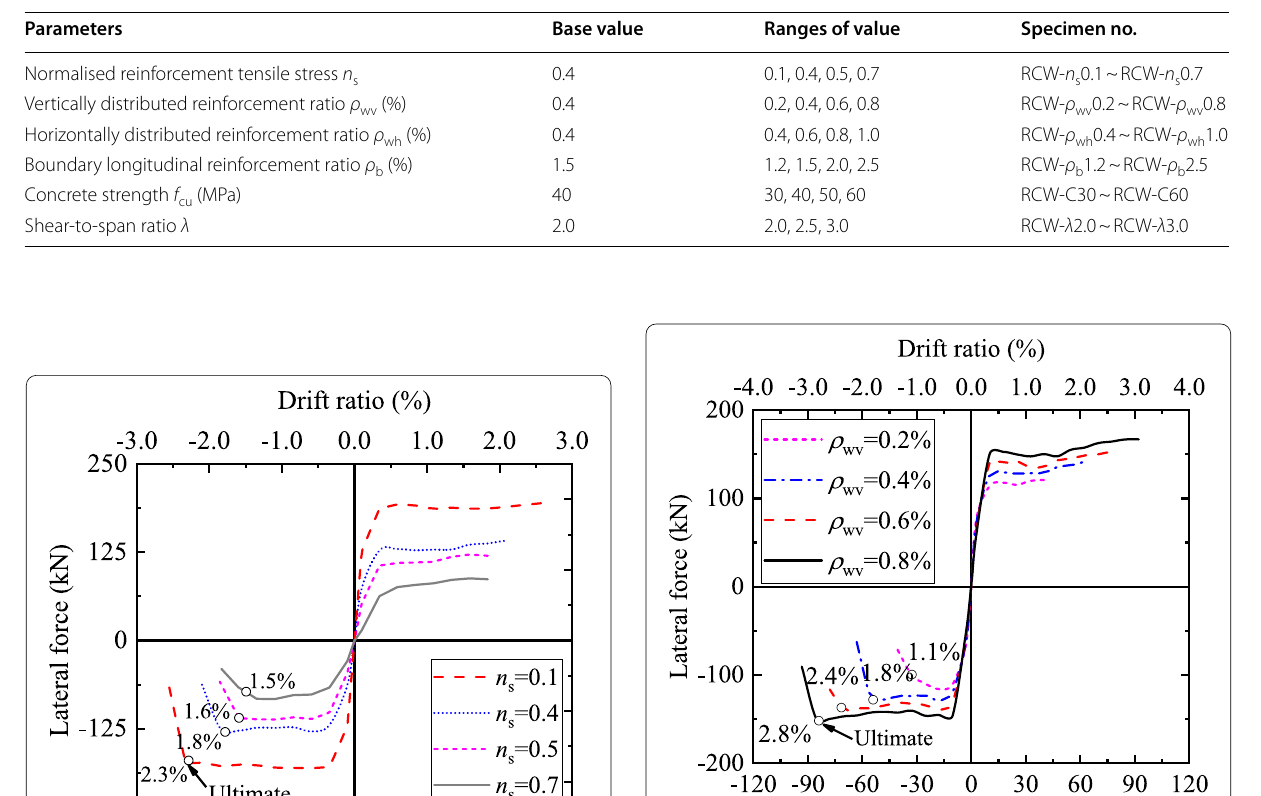
Table 4 Range of parameters of FEMs.